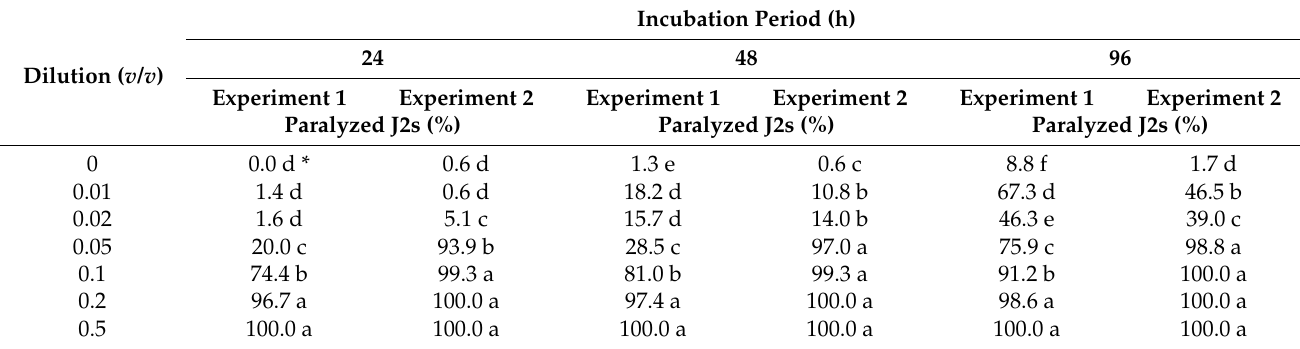
Table 5. Motility percentages of Meloidogyne javanica J2s after immersion in Cuminum cyminum seed hydrosol at 0, 0.01, 0.02, 0.05, 0.1, 0.2, and 0.5 v/v concentrations for 24, 48, and 96 h exposure